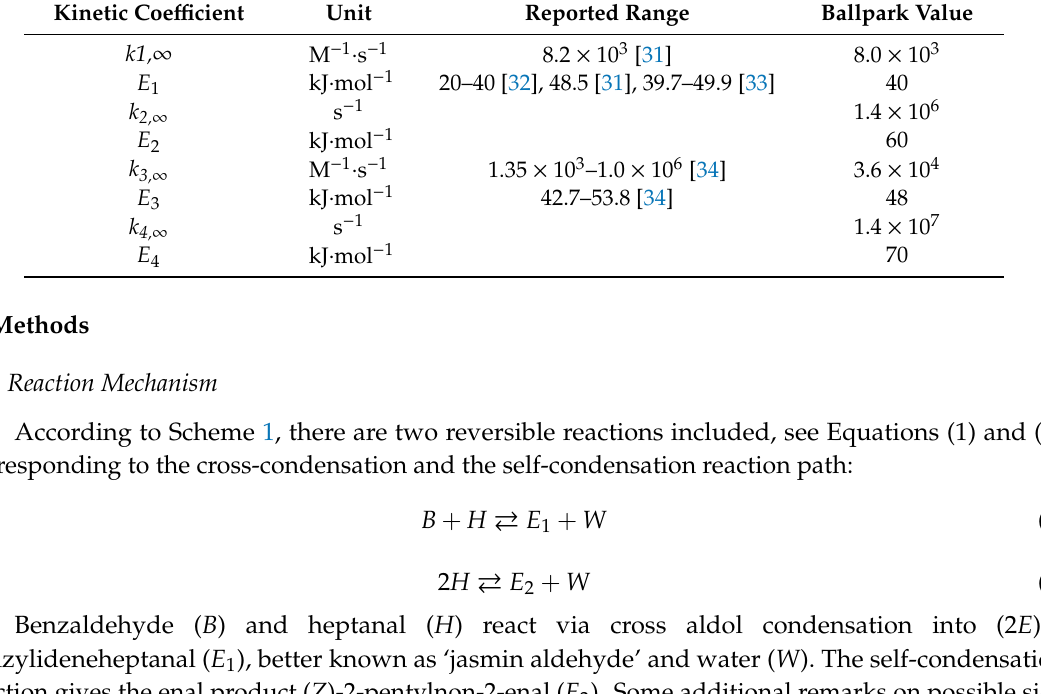
Figure 9. Activity coe ffi cient products for ( a ) B*H ; and ( b ) E 1 *W , present in reaction rate expression (4); ( c ) benzaldehyde conversion; and ( d ) selectivity towards product E 1 with ( B / H ) 0 = 2 mol · mol − 1 , T = 80 ◦ C with the solvents ( – ) toluene, ( – ) 1,4-dioxane, ( – ) DMF, ( – ) ethanol and ( – ) water. Table 6. Ballpark values for the kinetic coe ffi cients of the reactions given in Scheme 1. Kinetic Coe ffi cient Unit